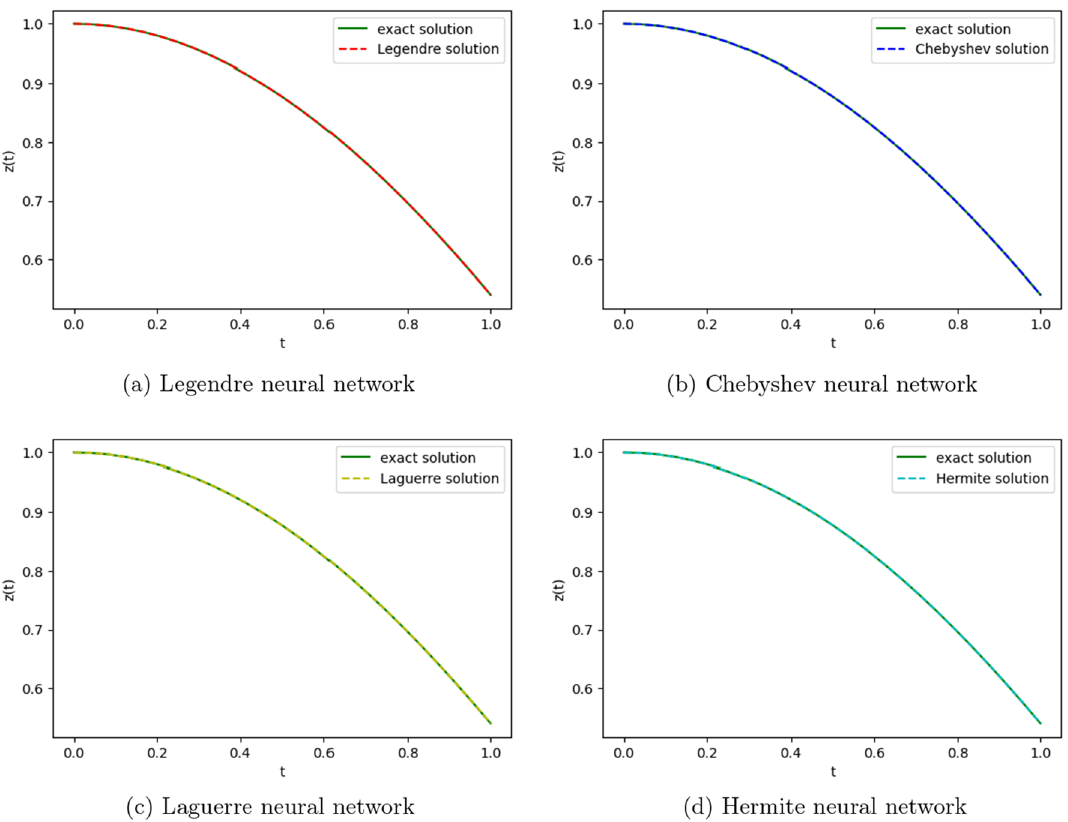
Figure 8. Comparison of the exact solution with the obtained approximate solutions of Example 6.4.